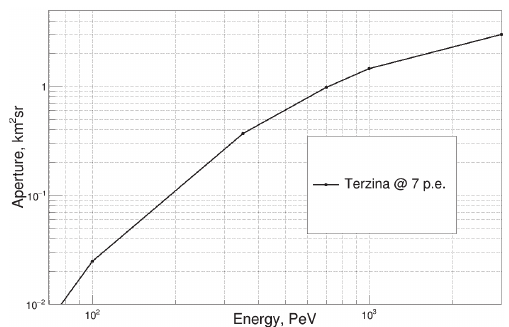
Figure 13: The expected aperture for Terzina versus proton en- ergy during the first year of